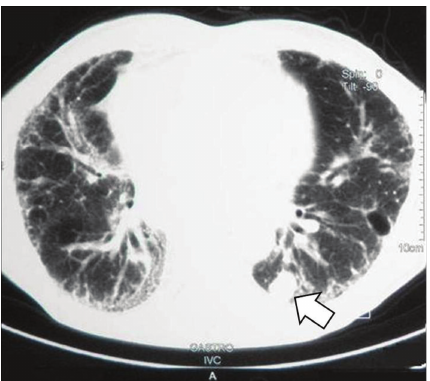
Figure 2: CT scan of a 72-years-old male with IPF and adenocarci-